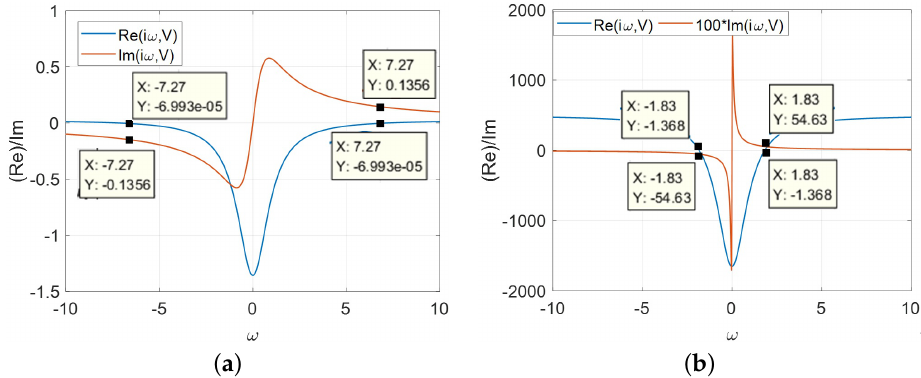
Figure 16. The frequency response, A = A FL > A M , Re [ Y ( i ω , V )] and Im [ Y ( i ω , V )] : ( a ) v ∈ LAD1; ( b ) v ∈